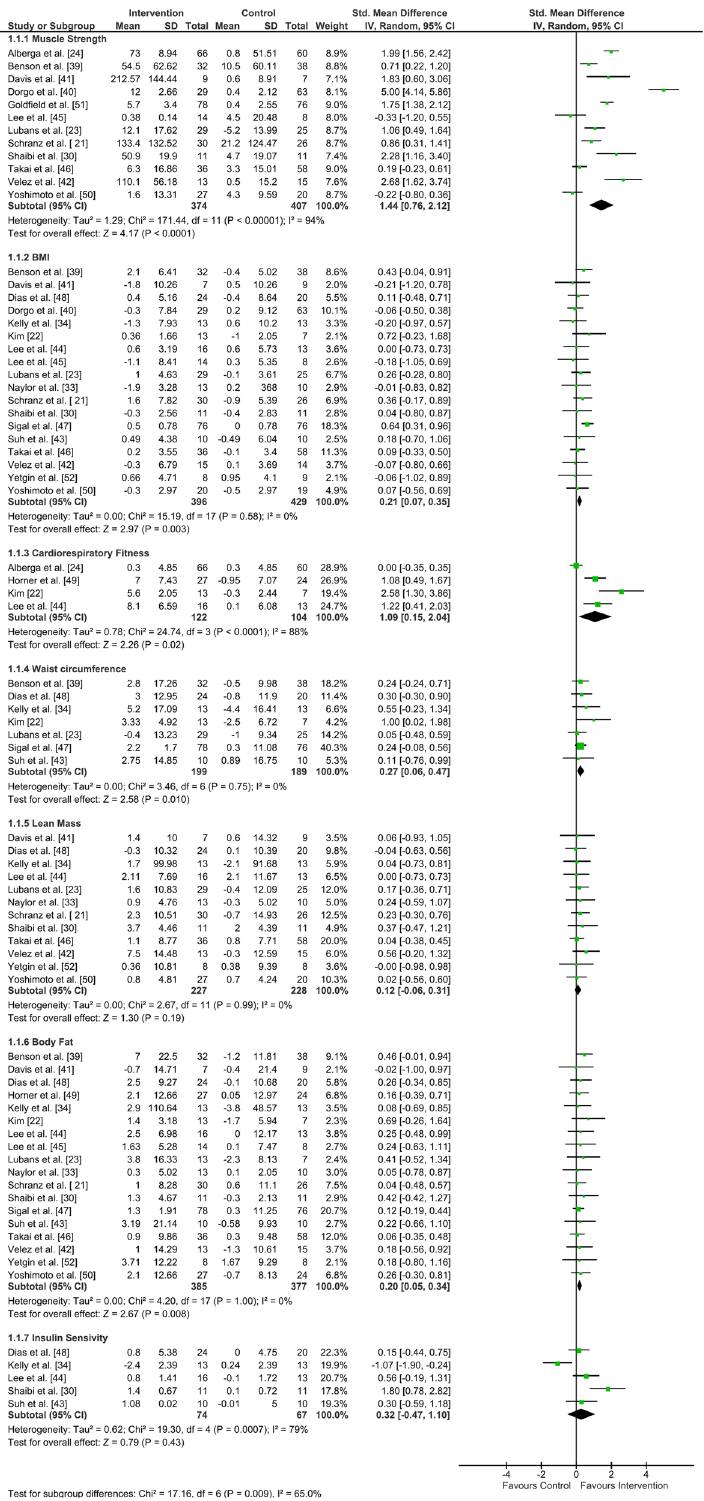
Fig. 1 Forest plot of comparison for muscle strength, body mass index (BMI), cardiorespiratory fitness, waist circumference, lean mass, body fat, and insulin sensitivity. The center of each square represents the standard mean difference for individual trials, and the corresponding horizontal line represents the 95% confidence interval (CI). The diamonds represent pooled